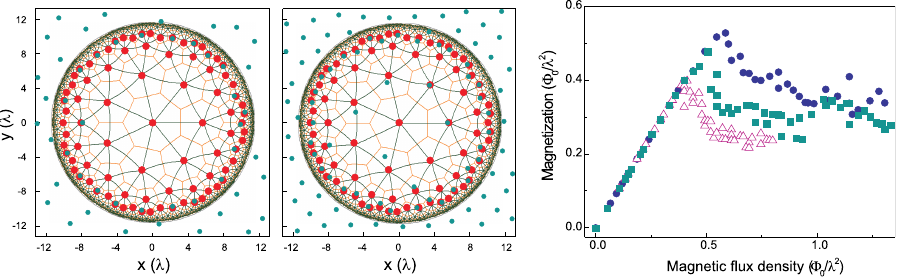
Fig. 3. Penetration of magnetic °ux in a HT array of pinning sites. For relatively low °uxes (left panel), the external magnetic °ux is shielded by the outer row of pinning sites giving rise to perfect diamagnetic response similar to that in a Meissner state of a superconductor. For increasing applied magnetic °ux (central panel), the °ux partially penetrates in the interior of the HT APS in a strongly heterogeneous way, in contrast to the conventional Bean-model scenario. The magnetization curves are shown in the right panel for varying pinning strength: f p = f 0 ¼ 1 : 2 (circles), 1.0 (squares) and 0.8 (open triangles). Note that for low values of the applied magnetic °ux, the magnetization grows linearly with the °ux with the slope equal to one, i.e., the interior of the device is fully screened by the outer shell of the pinning sites, similar to the Meissner e®ect. This e®ect weakens with decreasing pinning strength resulting in a weaker magneti- zation (as in samples without HT APS). HT APS displays a remarkable asymmetry in °ux entry and exit resulting in a strong hysteresis in the the magnetization (see Ref. 102). Due to the asymmetry in °ux entry and exit, this device can be used as a \°ux capacitor".